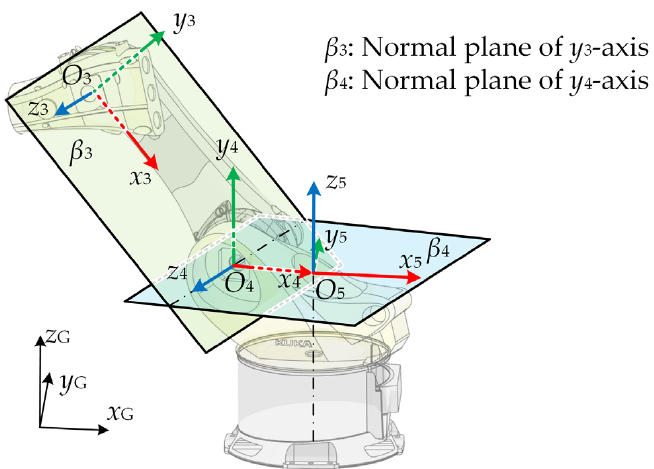
Figure 4. The calculation model of joint angle θ 4 .